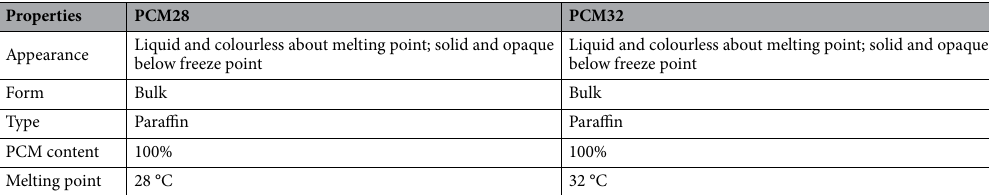
Table 1. Properties of PCMs used in the production of composite PAN/PCM nanofiber mats.